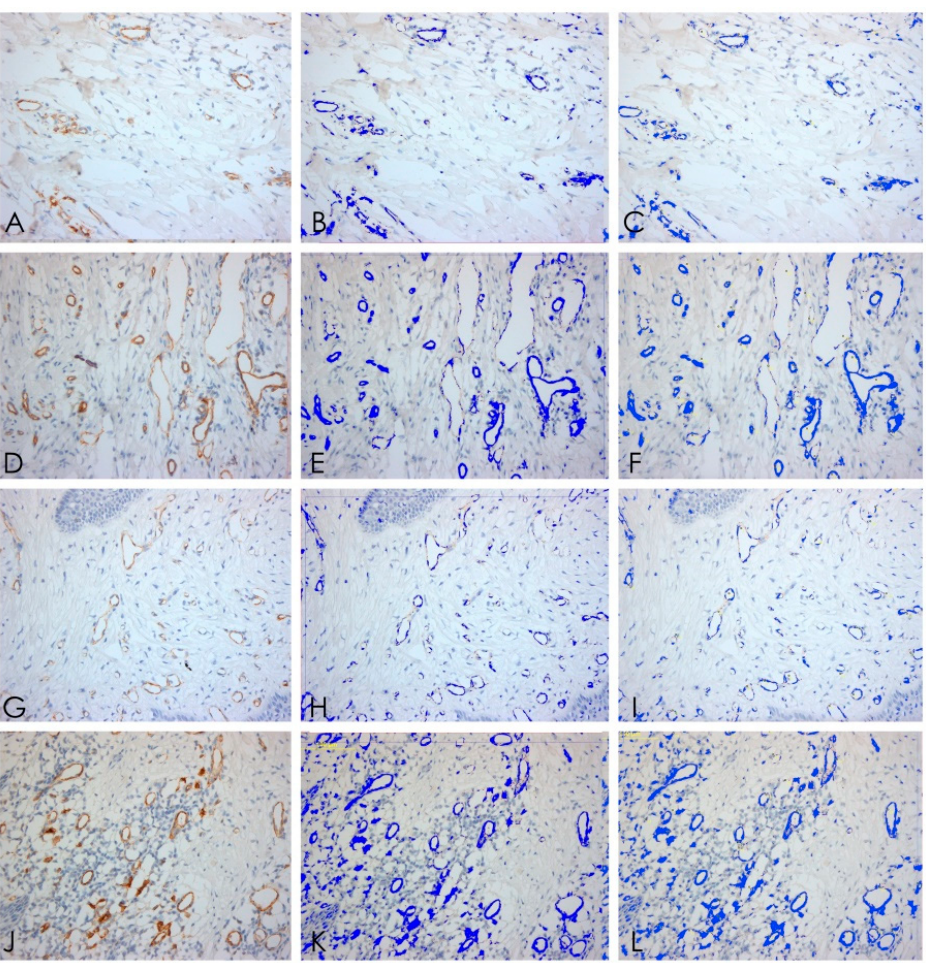
Figure 7. CD31. ( A – C ) Vessels expression T1, 20× ABC; and software analysis; ( D – F )